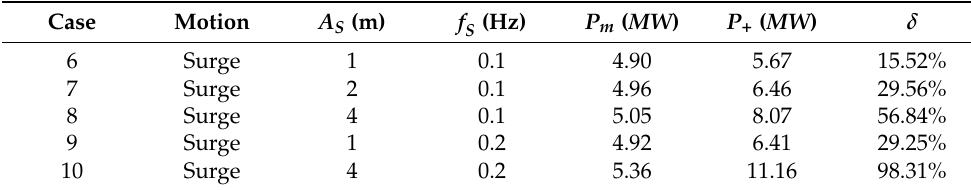
Figure 8. Surge motion analysis under case 10 ( A S = 4 m, f S = 0.1 Hz ). Table 5. Surge motion cases.